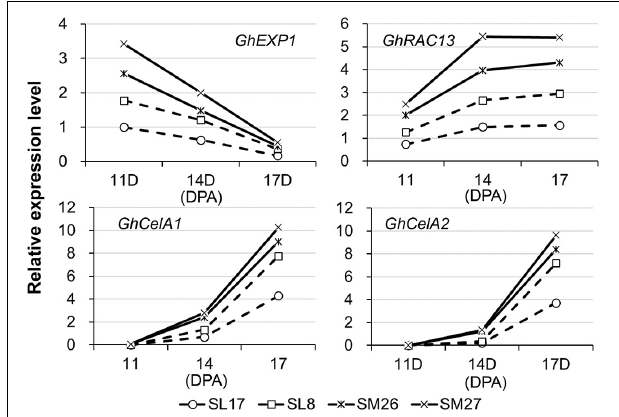
FIGURE 3 | Expression of cell elongation- and cellulose synthesis-related genes in developing fibers. SM, SCFP:iaaM transgenic cotton; SL, SCFP:iaaL transgenic cotton; DPA, day post-anthesis.